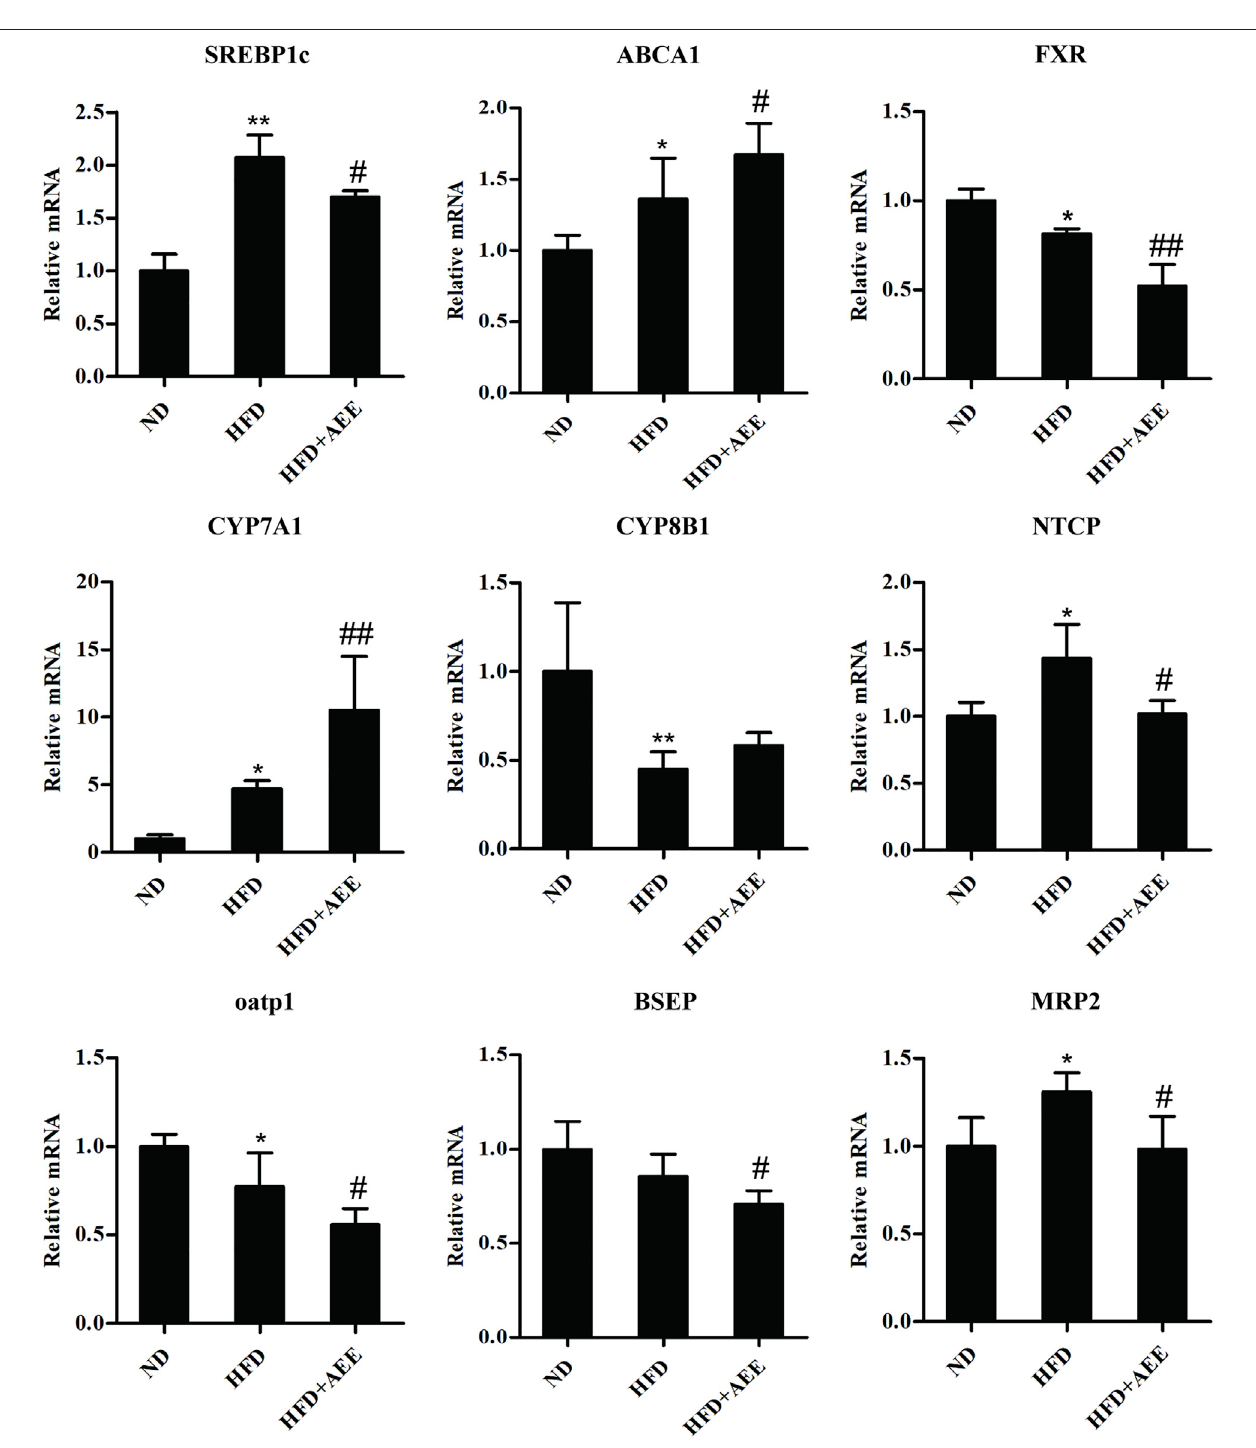
FIGURE 5 | Effects of AEE on mRNA levels of genes related with cholesterol and BA metabolism in hyperlipidemia rat. Data are expressed as the means ± SD ( n (cid:1) 10). ND, control group; HFD, high-fat diet; AEE, aspirin eugenol ester. * p < 0.05, ** p < 0.01 compared with the ND group; # p < 0.05, ## p < 0.01 compared with the HFD